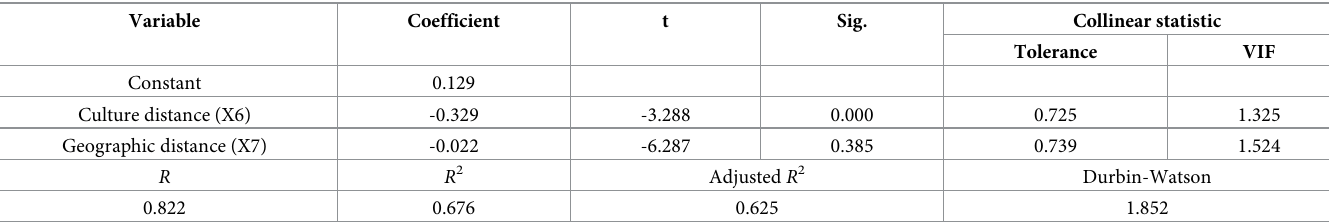
Table 13. Classified regression analysis results for organizational distance and knowledge transfer performance.